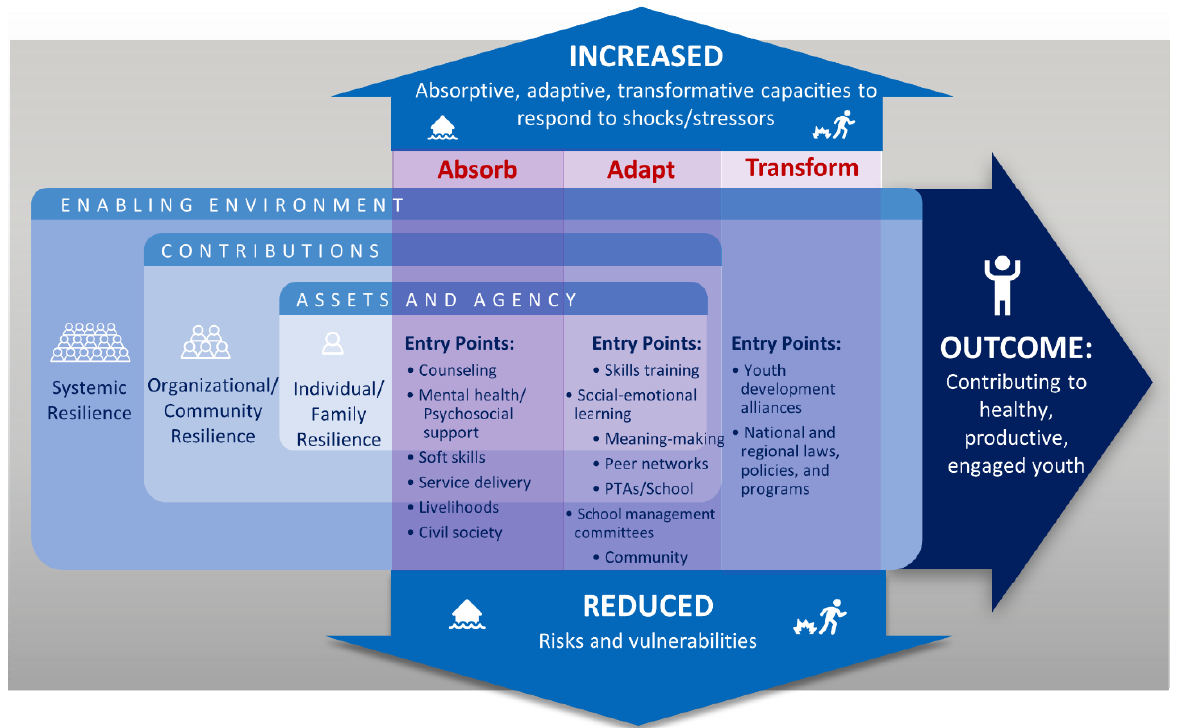
Figure 1. Resilience-Informed Positive Youth Development Programs Within a Socio-Ecological